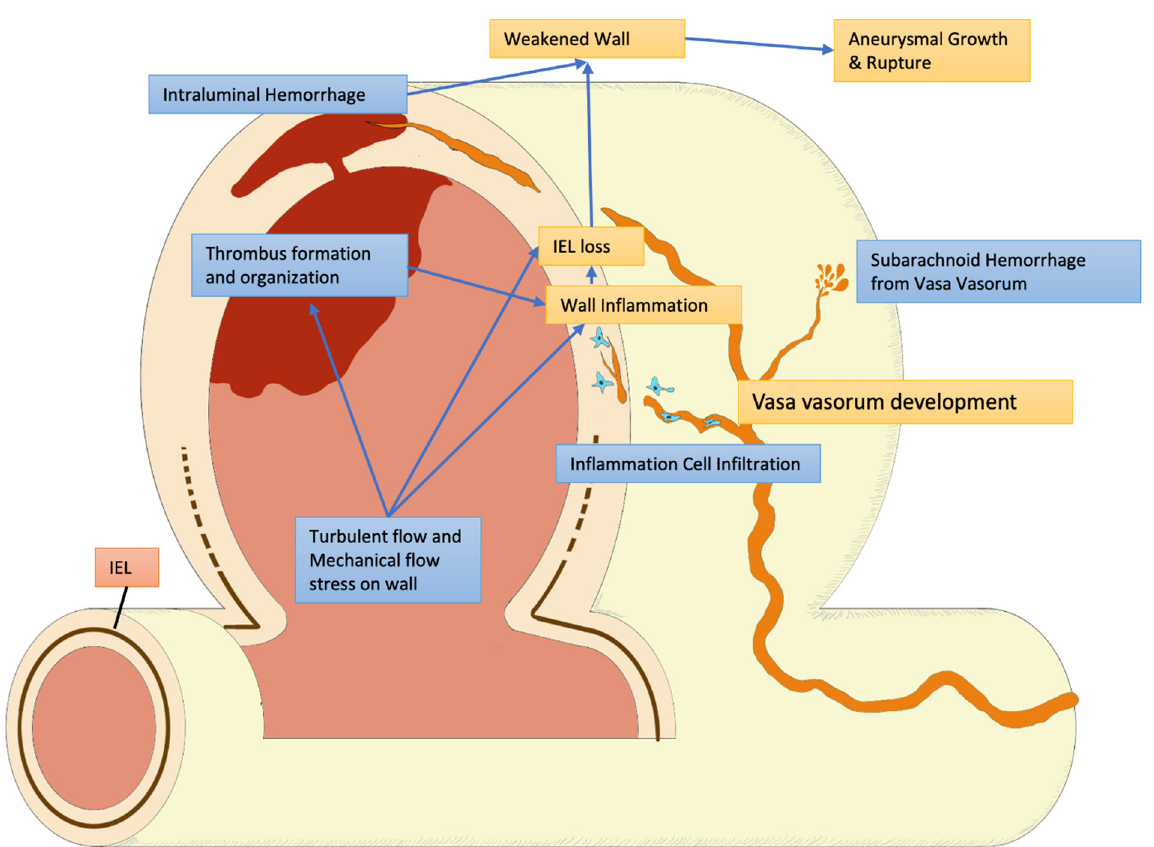
Figure 3. Pathophysiologic mechanisms of aneurysm development, growth, and rupture.